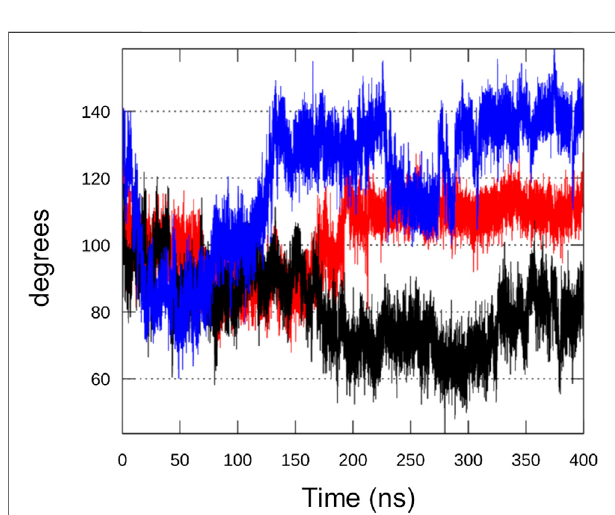
FIGURE 7 | Analysis of Rel Seq crystal-modelled interface. Angle formed between helices α 11 and α 13, the interface between the unaltered SYNTH (from1vj7.pdb) andthehomology modeledportion,duringreplica#1(red), #2 (black) and #3 (blue) calculated from the scalar product of the two vectors that run along the two